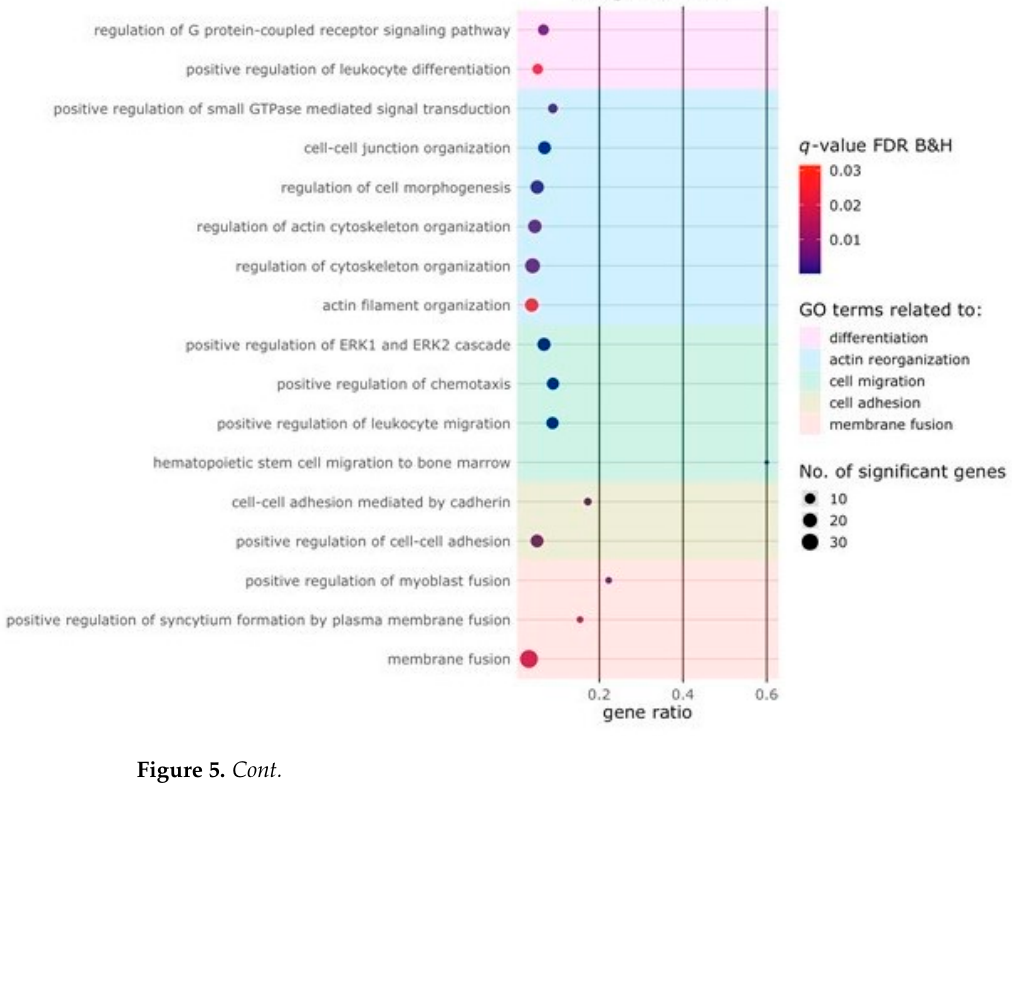
Figure 5. Gene ontology terms in the biological process domain. Bubble plot showing selected Gene Ontology (GO) terms in the biological process domain enriched among the genes that were upregu- lated or downregulated by the Activin-A treatment. The size of the circle represents the number of DEGs ( p (adj) < 0.01, Log2 fold change ≥ 2) in that pathway. The color of the circle represents the sig- nificance depicted as a q-value, with the default settings of the Benjamini–Hochberg false discovery